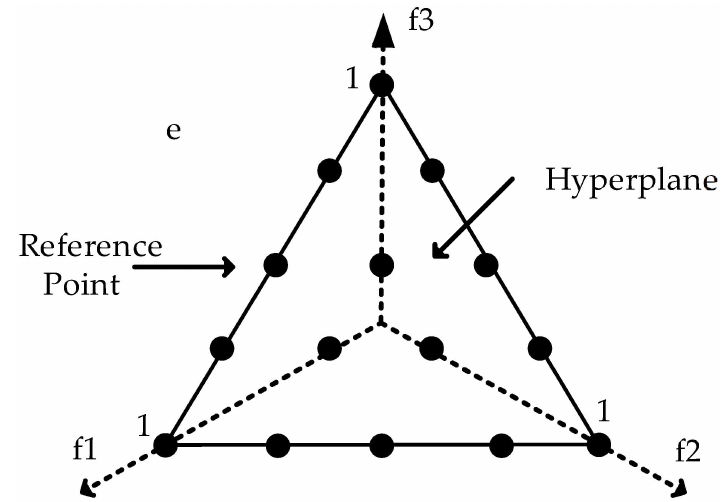
Figure 2. The reference points for three-objective optimization